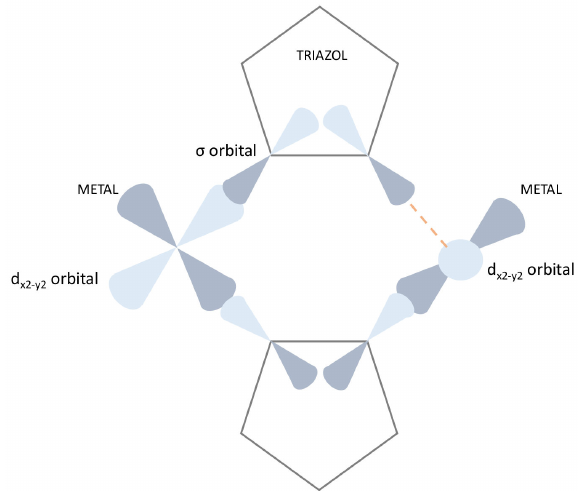
Figure 4. Schematic representation of magnetic molecular orbitals in triazole-bridges complexes. The bridge in the bottom represents the σ overlap for an efficient AF exchange propagation. The bridge in the top represents an absence of orbital overlapping (dotted orange